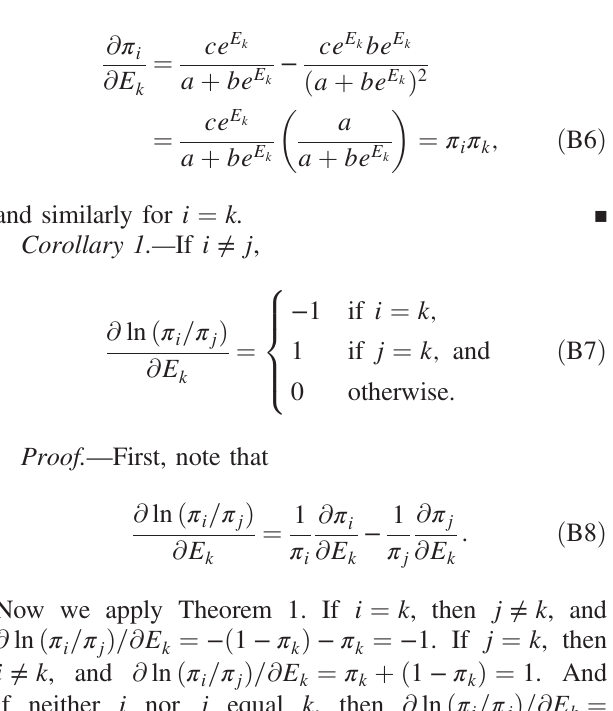
FIG. 9. Vertex perturbation. Groupings of spanning trees with roots labeled in blue for π 1 ( i ¼ 1 ) utilized in the vertex perturbation derivation when the perturbed vertex is k ¼ 4 , labeled in red. Affected rates are labeled in